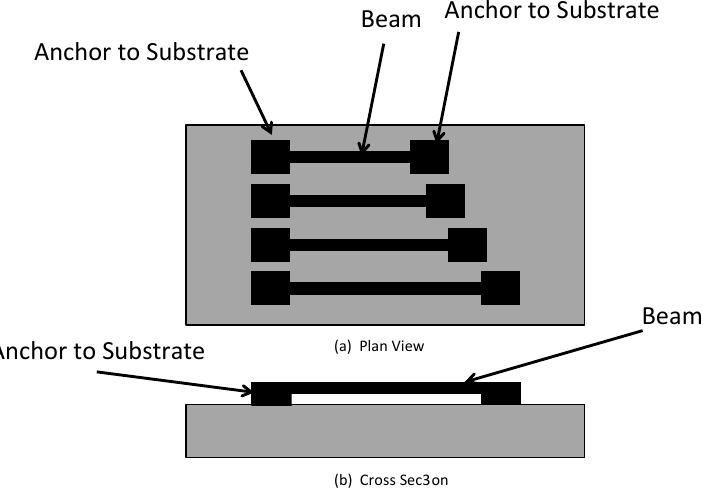
Figure 6. ( a ) Plan view of the fixed-fixed beam array having different lengths used to determine the critical length. ( b ) cross-section of the longest beam.